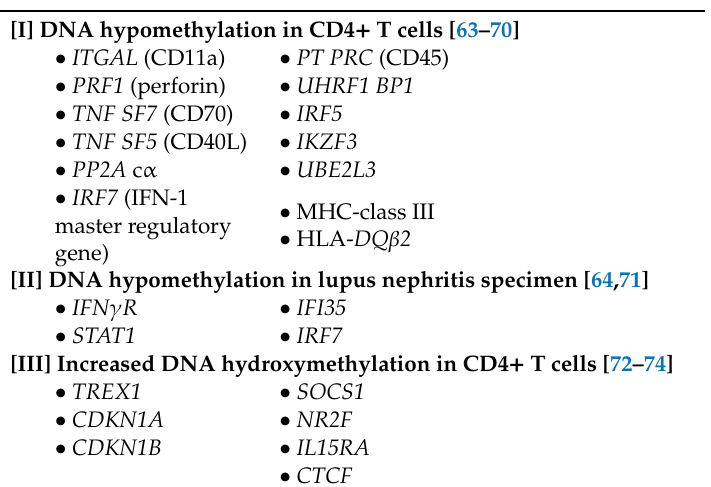
Table 3. Epigenetic regulations of genes in patients with